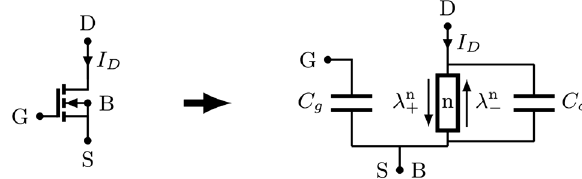
FIG. 8. Model of an nMOS transistor as an externally controlled conduction channel between source and drain, with associated Poisson rates λ n . The gate-body interface is represented as a (cid:2) capacitor C , and another capacitor C takes into account the g o output capacitance. This model is just a minimal model and does not pretend to be realistic. Other parasitic capacitances could also be taken into account, for example, between drain and gate, but a proper description of them must take into account the physical dimensions of the